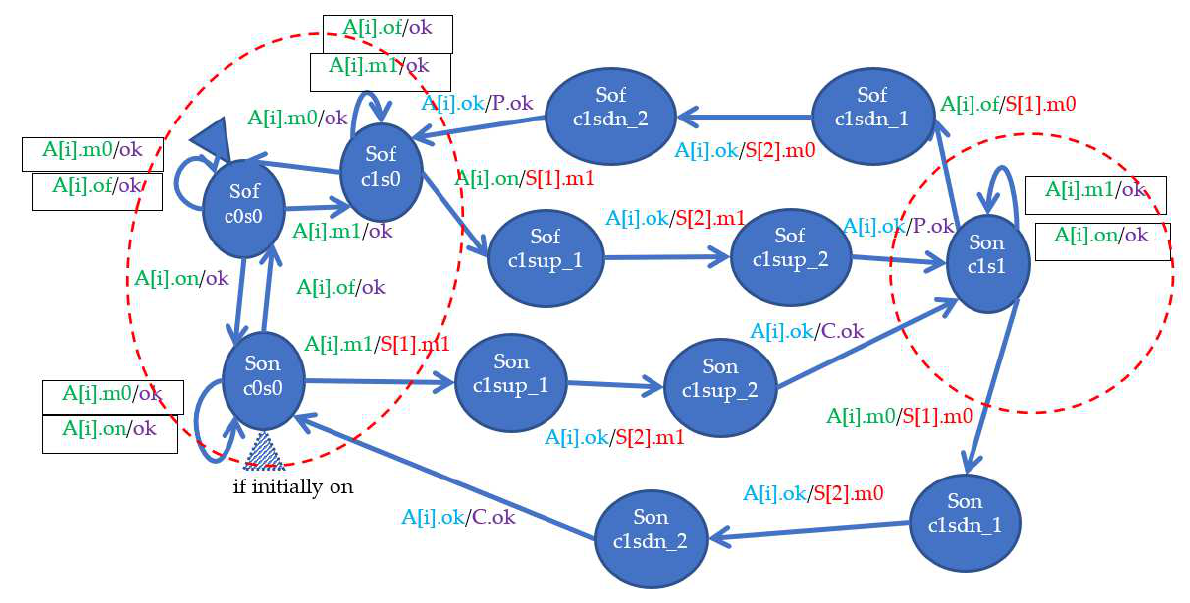
Figure 6. Model of connector/switch. P and C.